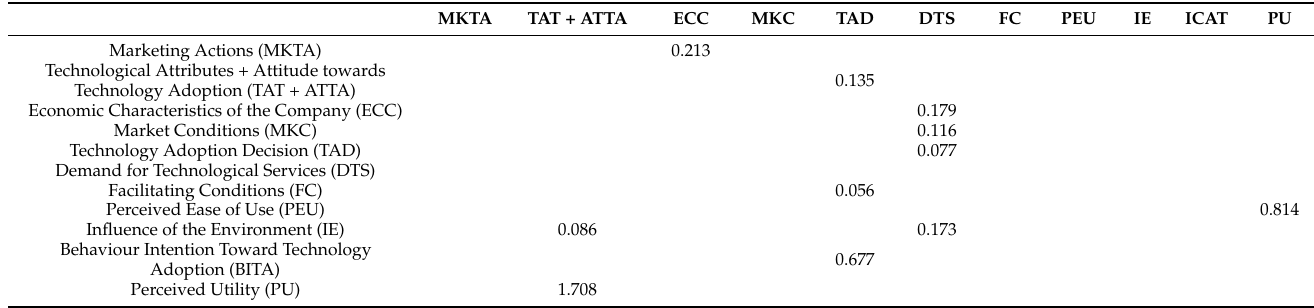
Table 10. f 2 Effect